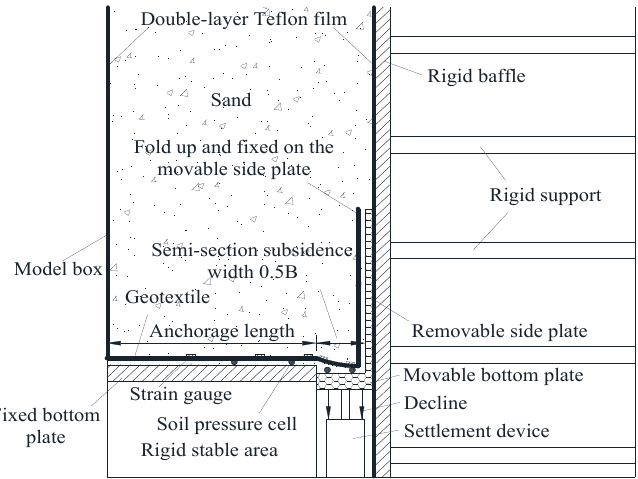
Figure 1. Sketch graph of the geotextile of half-symmetric model.